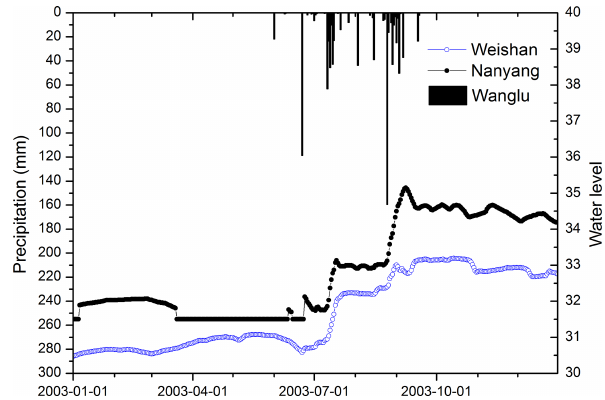
Figure 5. Rainfall at Wanglu station in the NLB and water level variations in the upper lake and lower lake in 2003. The upper lake is dry when the water level of NY is 31.5m. Before July 2003, the NLB suffered severe drought, but heavy rains in August caused se- rious